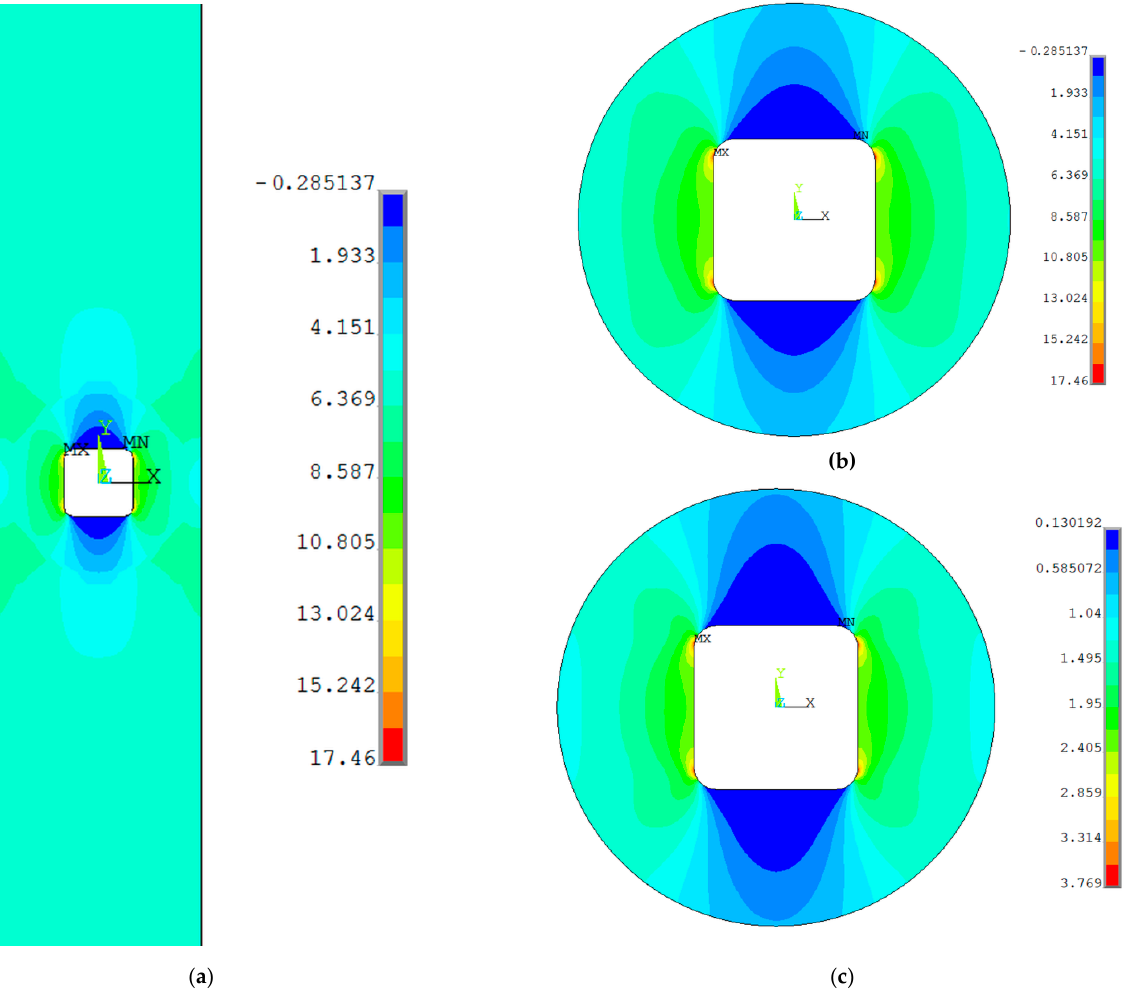
Figure 23. Distribution of tension stress σ y in steel panel for circular patch overlay with R ov = 20.0 mm and θ = 0°: ( a ) in the whole sample; ( b ) in steel part area under patch; ( c ) in composite layer.